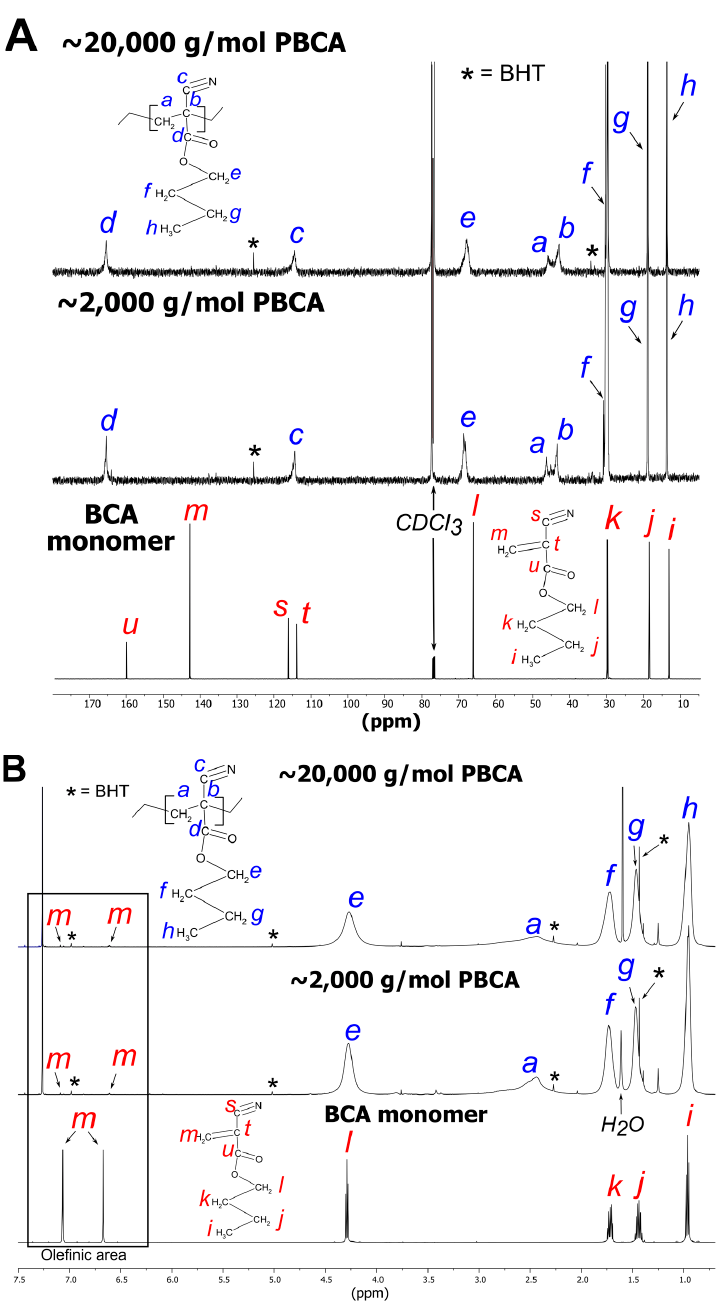
Figure 7. ( A ) The 150 MHz 13 C NMR spectra of 2000 g/mol PBCA, 20,000 g/mol PBCA and BCA monomer with molecular structure peak assignments; ( B ) The 600 MHz 1 H NMR spectra of 2000 g/mol PCBA, 20,000 g/mol PBCA and monomer with molecular structure peak assignments. Signals associated with butylated hydroxytoluene (BHT) impurity are marked as *. 7A). In addition, the 1 H spectra of the 2000 g/mol and 20,000 g/mol PBCA batches showed